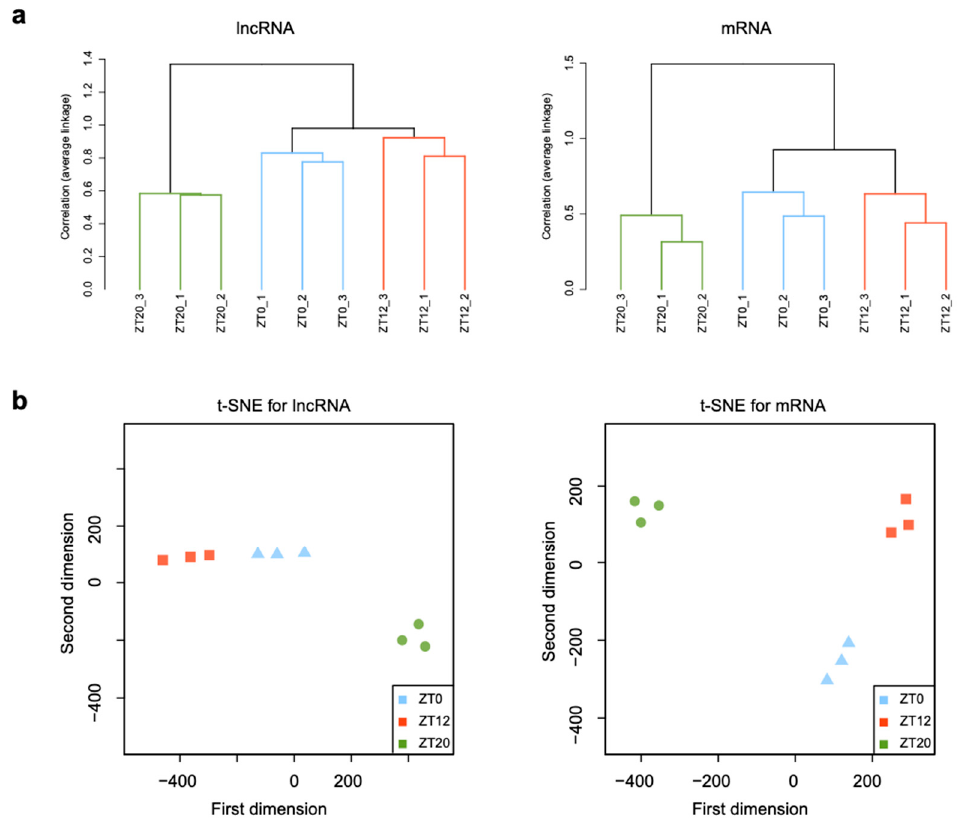
Figure 2. Global gene expression profiles of the F1 follicle during development. Hierarchical clustering of all samples ( a ) and t-SNE plot ( b ) of lncRNAs and mRNAs based on expression profiles in different development stages. The top and left panel is the sample and gene tree, and the value represents the log2 transformed values of (TPM + 1). ZT0 (9:00 a.m.), ZT12 (9:00 p.m.), and ZT20 (5:00 a.m.) represent the early, middle, and LH surge stages, respectively, of the ovulatory cycle.